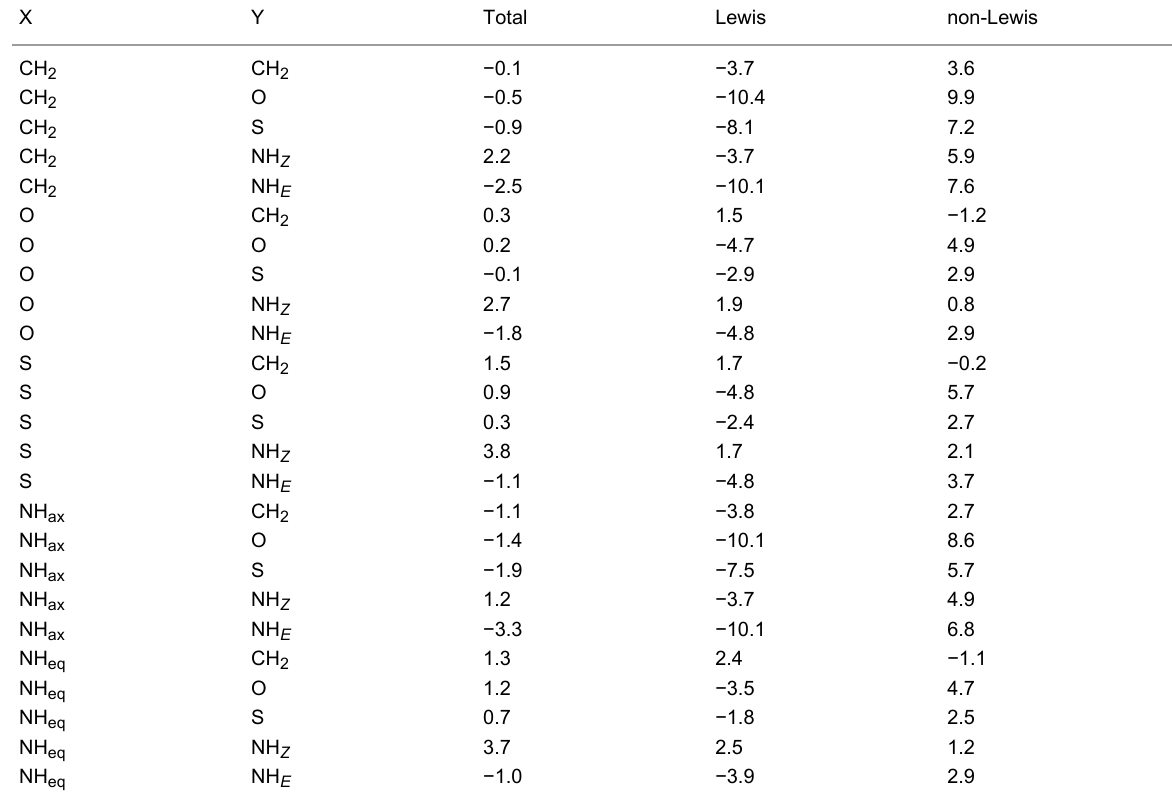
Table 2: Relative electronic energies ( Δ E ax–eq ) from NBO analysis (total, Lewis and non-Lewis energies, in kcal mol − 1 ) in vacuum. X Y Total